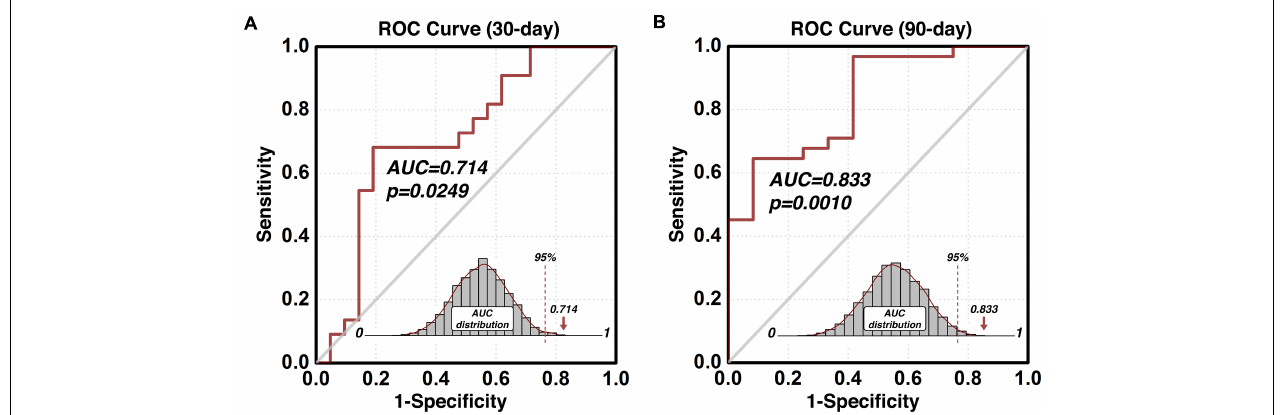
FIGURE 4 | Predict validity of the early and intermediate relapse prediction models. The prediction accuracy using the functional circuits of the identified predictive dlPFC ROI is illustrated in panel (A) for the early relapse prediction model where the follow-up cut-off is at 30 days, and in panel (B) for the intermediate relapse prediction model where the follow-up cut-off is at 90 days. ROC, Receiver-Operating-Characteristics; AUC, area-under-the-curve; dlPFC, dorsolateral prefrontal cortex; ROI,